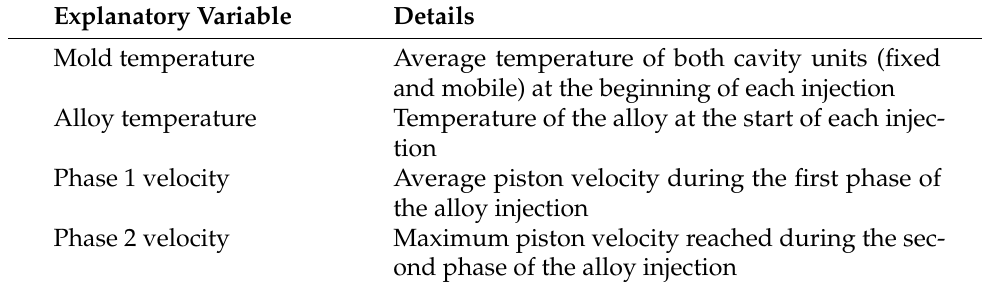
Table 1. Explanatory variables.